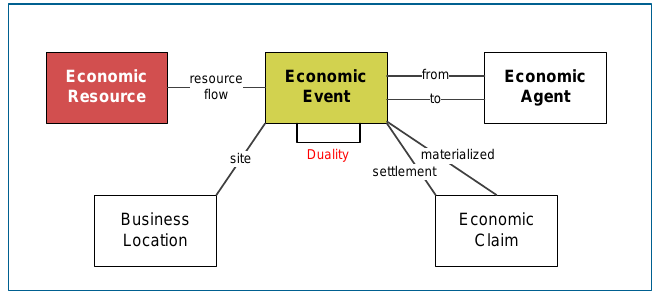
Figure 2. REA Accounting model [12] – UML